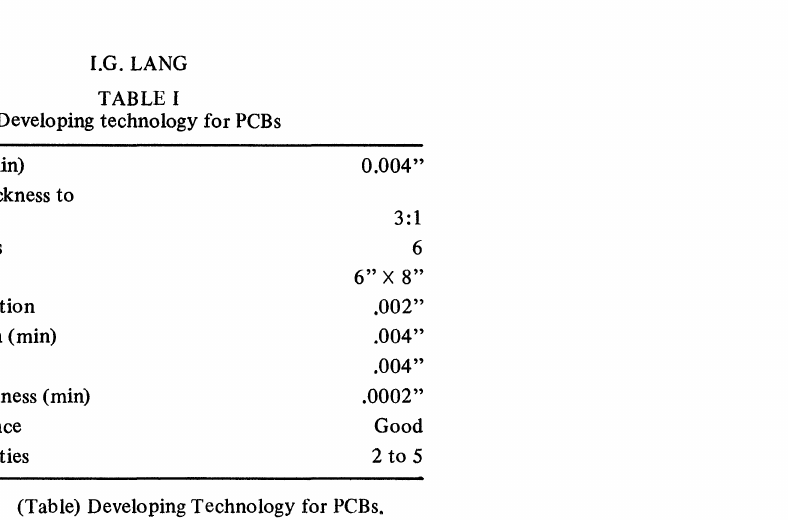
(Table) Developing Technology for